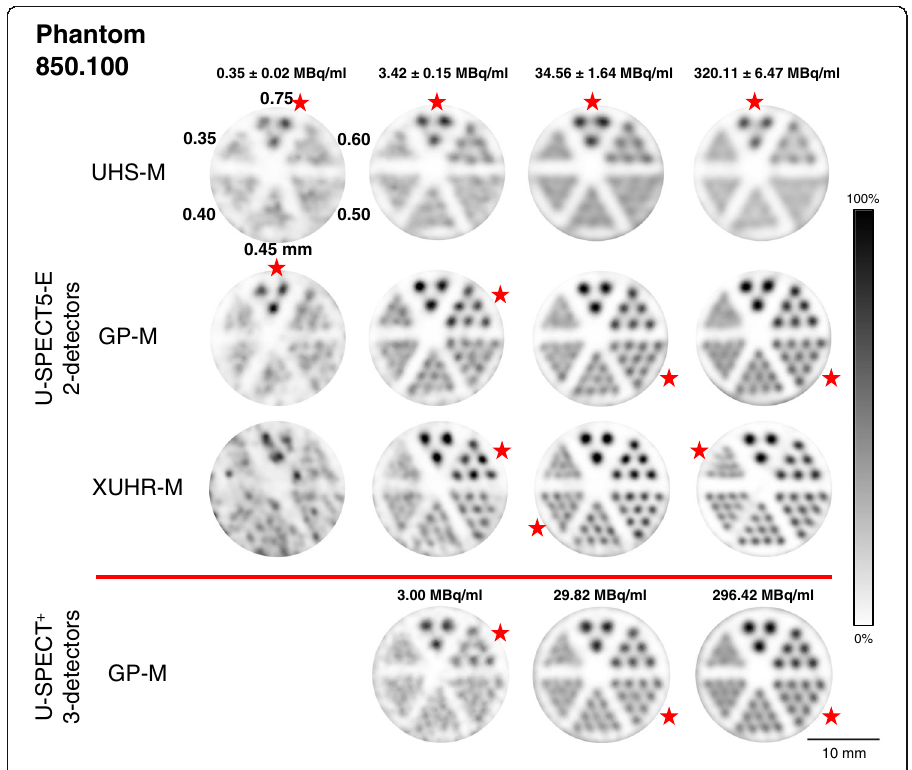
Fig. 5 Reconstructed SPECT images of the mini Derenzo phantom 850.100 with various activity concentrations (mean ± standard deviation) of 99m Tc for a 300 s TPB scan (9 BP 2DT-Scanner, 12 BP 3DT- Scanner). Rod sections marked with the red star were assumed to be the smallest diameter resolved. All images are shown with 6.0 mm slice thickness and 0.35 mm full width half maximum Gaussian